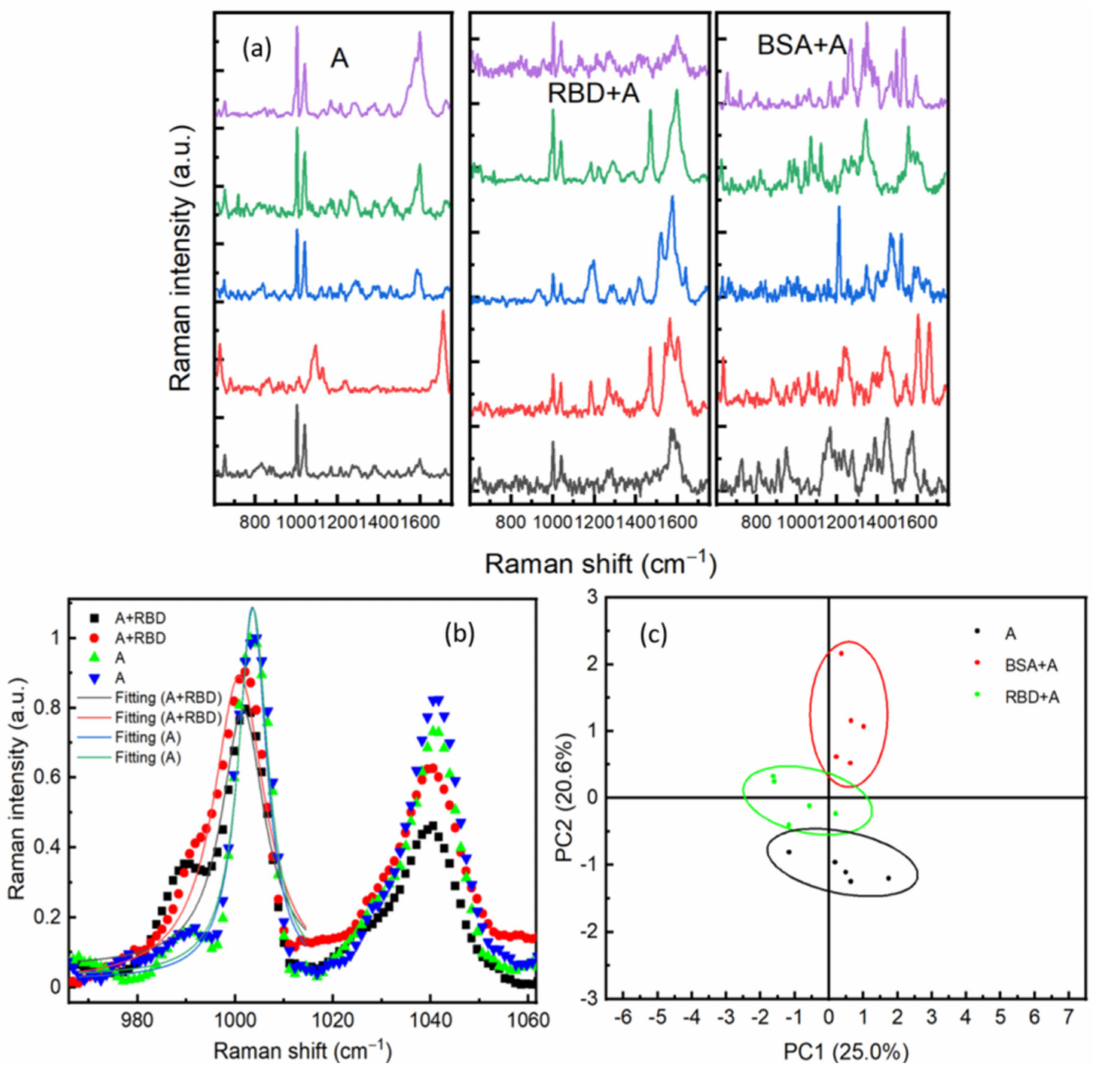
Figure 7. ( a ) SERS spectra performed on different positions respectively on antibodies, RBD on antibodies (RBD + A), and bovine serum albumin (BSA). ( b ) A comparison between SERS spectra of RBD + A and A in two positions; fitting of the Raman line with a Lorentzian function of RBD + A at 1001 cm − 1 and A at 1003 cm − 1 . ( c ) Principal component analysis of SERS spectra for Antibody, RBD, and